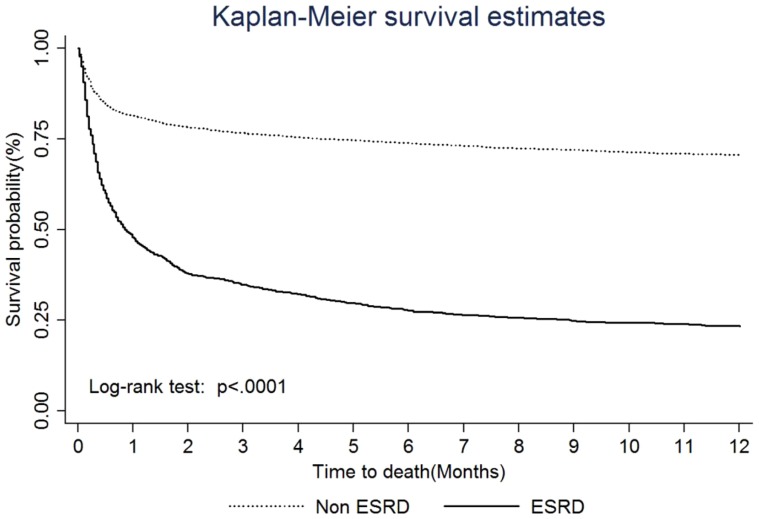
Kaplan-Meier survival curves for mortality of TBI surgery patients with and without pre-existing ESRD.